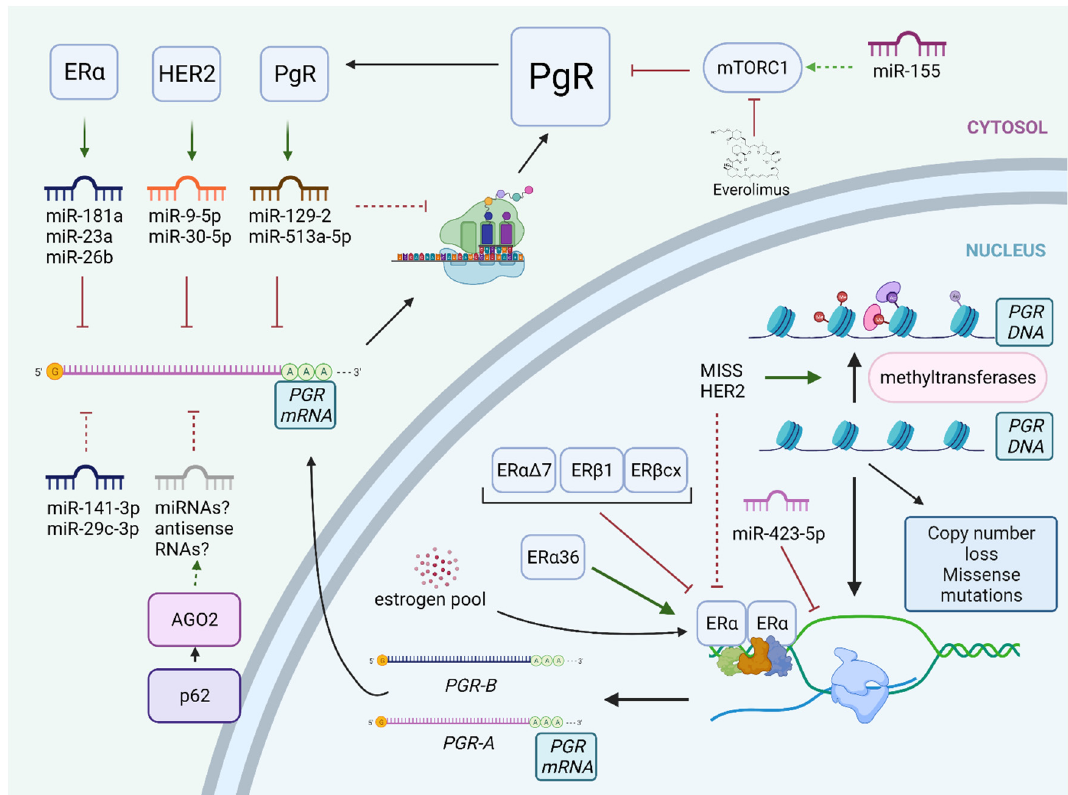
Figure 2. Pre-translational mechanisms of PgR loss and down-regulation. Green arrows indicate stimulatory effects, red T-shaped lines depict inhibitory effects, dotted lines show potential effects. At pre-transcriptional stage, PgR loss is a consequence of methylation of PGR promoter, copy number loss (often), or mutations (very rarely). Splice variants of ER α and ER β may either suppress or activate the transcription of PGR . Low levels of estradiol after menopause are frequently insufficient to induce expression of PgR. PGR mRNA is a direct target of multiple miRNAs, but some miRNAs may down-regulate PgR indirectly, e.g., via activation of mTORC1. For details, see text. Abbreviations: AGO2—protein argonaute-2; ER α —estrogen receptor α ; HER2—human epidermal growth factor receptor 2; miRNAs—microRNAs; MISS—membrane-initiated steroid signaling; mTORC1—mammalian target of rapamycin complex 1; PGR —progesterone receptor gene; PgR—progesterone receptor. Created with BioRender.com — accessed date 22 September 2021.